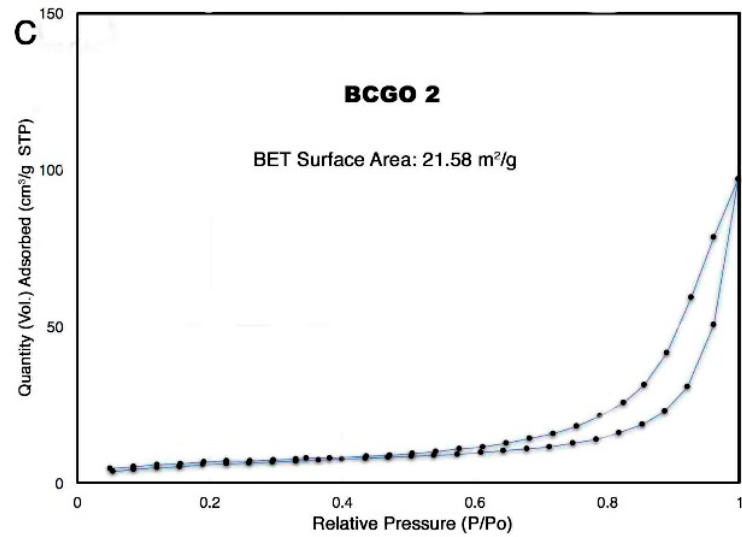
Figure 6. Nitrogen adsorption/desorption (at 77 K) curves (specific surface area) distribution curves of ( A ) BC, ( B ) BC/GO 1 and ( C ) BC/GO 2.